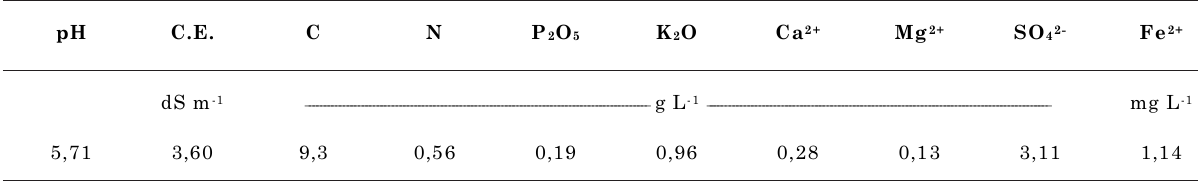
C.E. = condutividade elétrica.